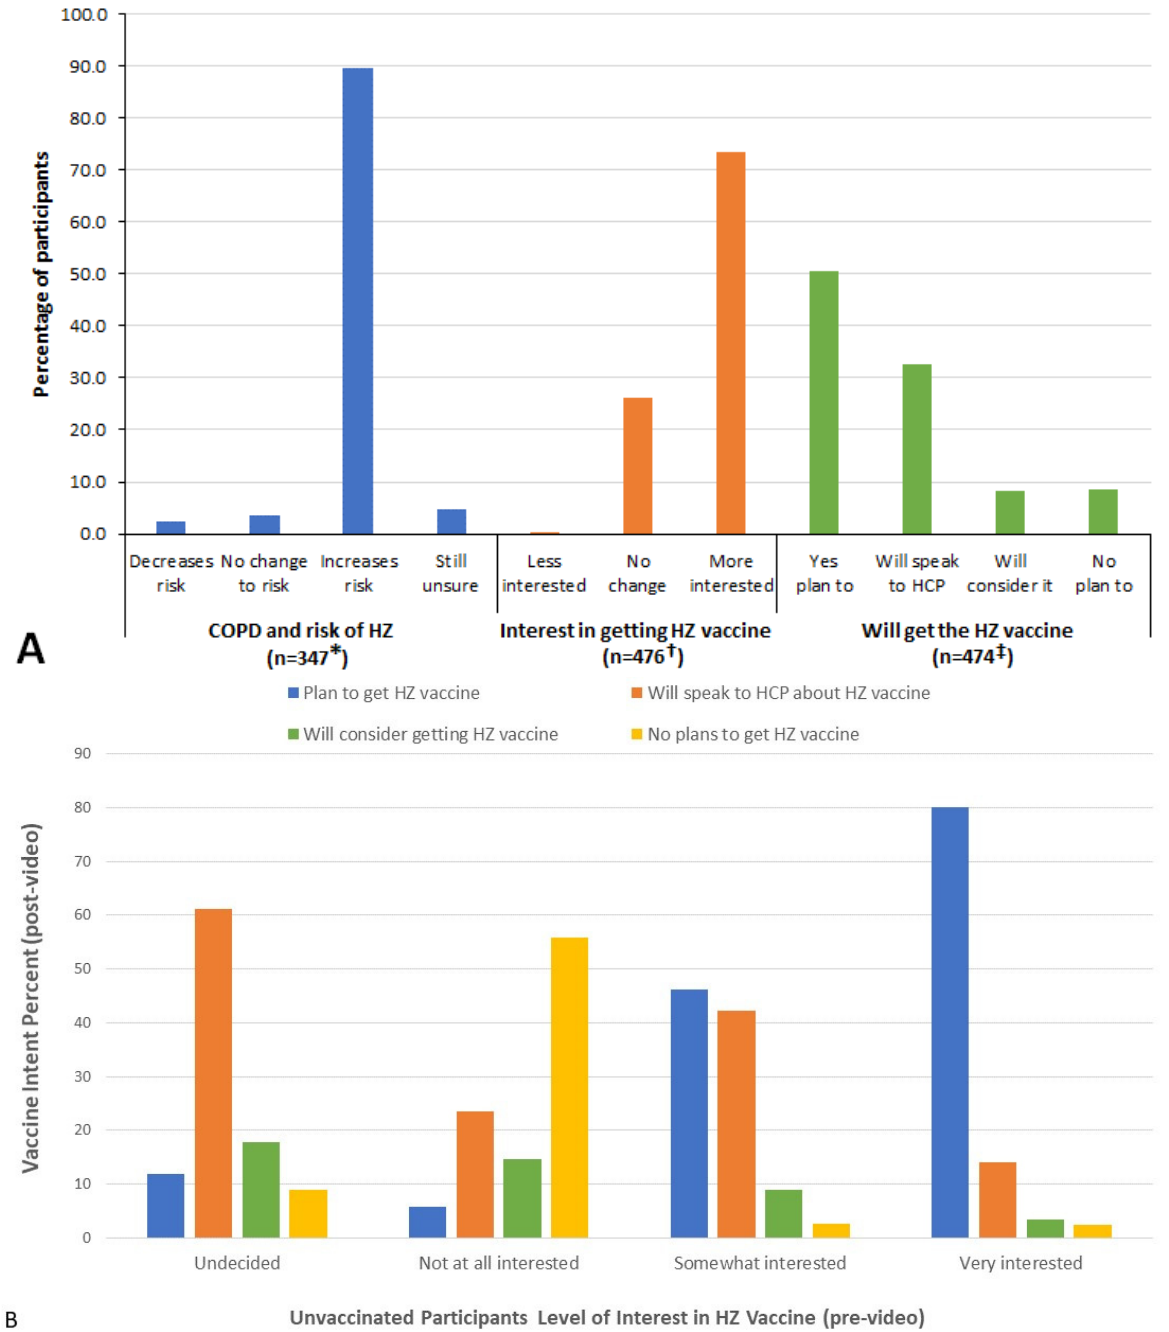
Figure 3. Changes after watching the educational video in ( A ) participants’ understanding of HZ risk and intent to get vaccinated, and ( B ) vaccine intent post-video versus level of vaccine interest pre-video in those not yet vaccinated. * Participants who reported before watching the video that they did not think that COPD increased the risk of HZ. † Participants who completed Part 2 of the survey. ‡ The two participants who answered that they were less interested in getting the HZ vaccine were not asked whether they now planned to get the vaccine (per the survey skip pattern). Abbrevi- ations: COPD, chronic obstructive pulmonary disease; HCP, healthcare professional; HZ, herpes zoster.